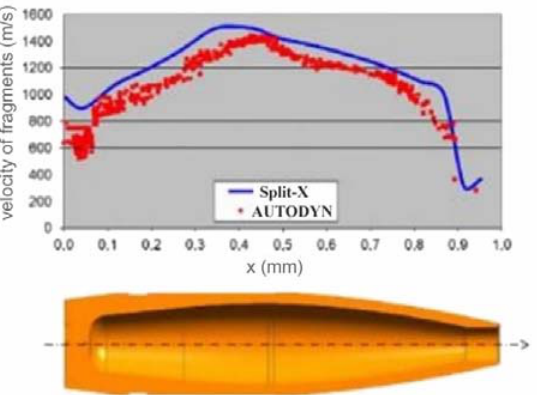
Figure 5. Initial velocities fragments for 155mm M107 (Split-X and AUTODYN)